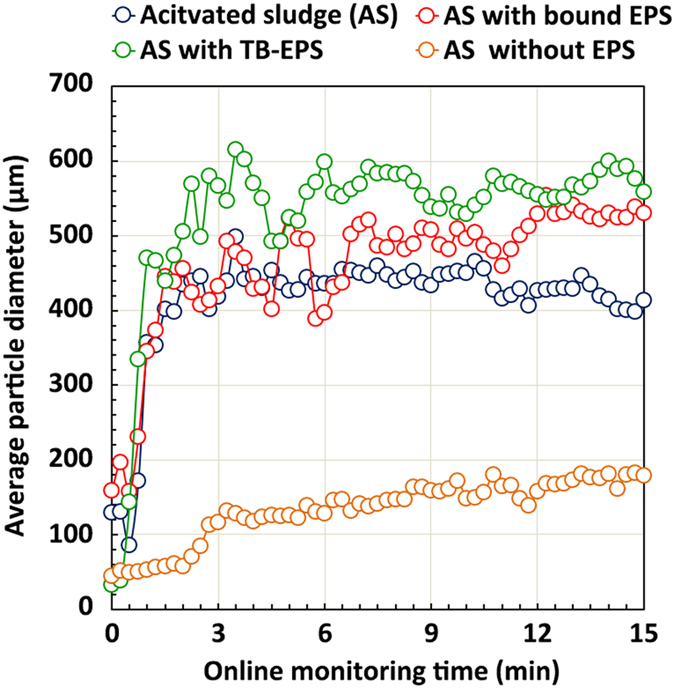
Effects of the components of various extracellular polymeric substances (EPS) on sludge aggregation performance, represented by changes in average particle diameter of flocs over time.